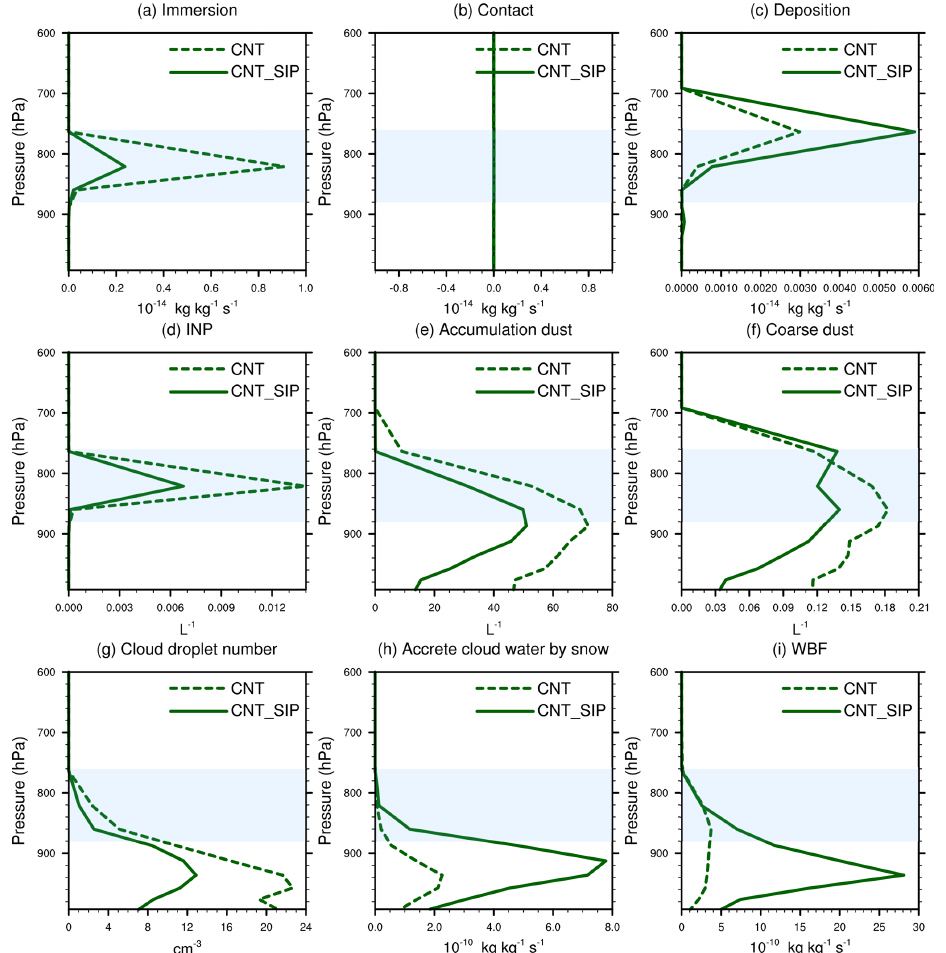
Figure 9. Vertical profiles of (a) ice production rate (unit: kgkg − 1 s − 1 ) from immersion freezing of cloud water, (b) ice production rate (unit: kgkg − 1 s − 1 ) from contact freezing of cloud water, (c) ice production rate (unit: kgkg − 1 s − 1 ) from homogeneous and heterogeneous deposition nucleation, (d) immersion freezing INP number concentration, (e) cloud-borne dust number in the accumulation mode, (f) cloud- borne dust number in the coarse mode, (g) cloud droplet number concentration, (h) accretion rate of cloud droplets by snow, and (i) WBF process rate from CNT and CNT_SIP experiments averaged over the single-layer mixed-phase cloud period. Light blue shadings indicate the ice nucleation regime. Ice production rates are grid-box